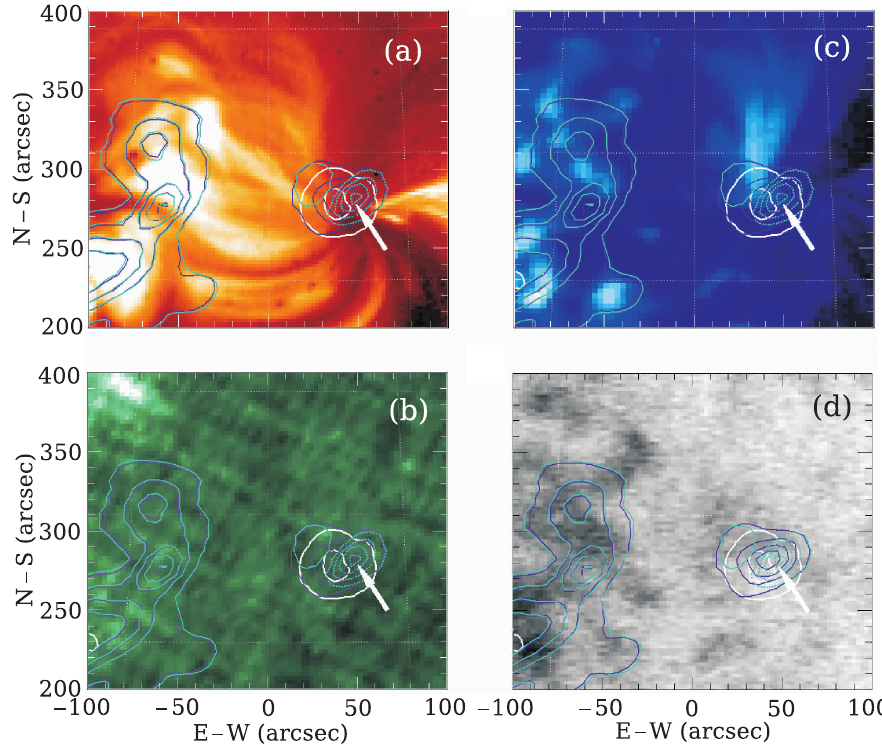
Fig. 2. AR 11312 on October 11. Contours of the 17 GHz radio brightness taken with the NoRH in LCP (violet color) and RCP (azure color) at the levels (12, 15, 18, 21, 24) (cid:2) 10 3 K and the dotted line at 6.5, 7.5, 8.5, 9.5) (cid:2) 10 3 K levels at 01:00 UT are overlaid on: (a) the soft X-ray image taken with the XRT onboard Solar-B at 06:29 UT, (b) the NoRH image of the 34 GHz intensity taken at 02:44 UT, (c) EUV 1.74 10 (cid:0) 8 m image taken with the help of the SWAP with Al (cid:12)lter onboard the PROBA2 at 00:59 UT, and (d) the image in the chromospheric absorption line He I 1.083 (cid:22) m taken with the CHIP on the Mauna Loa Solar Observatory at 01:00 UT. Note the faint emission in both coronal (a, c) and chromospheric (b, d) levels of the atmosphere above the northern part of the sunspot. Contours of the sunspot umbra and penumbra are marked by the white